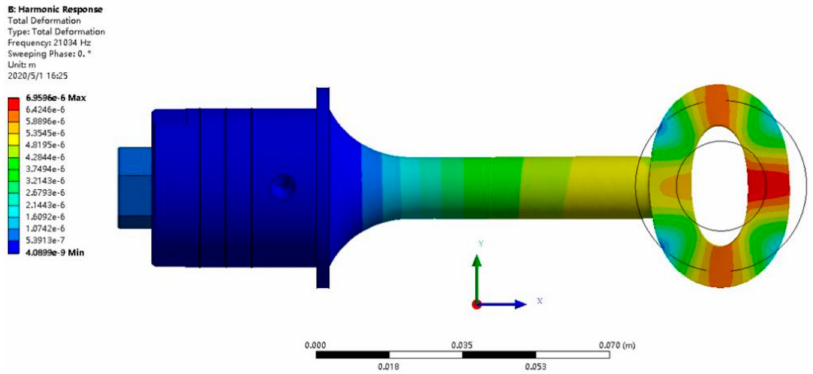
Figure 1. The harmonic simulation result at about 21 kHz.